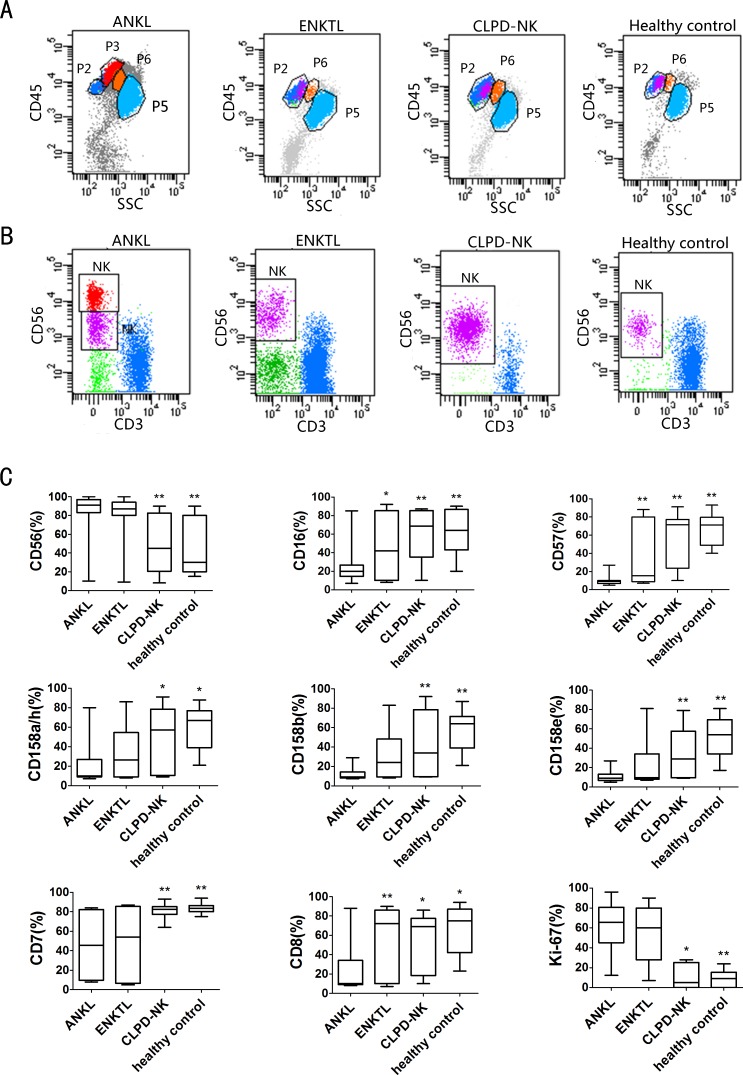
Comparison of immunophenotypic characteristics among samples from different NK diseases and healthy control detected by flow cytometry.(A) Abnormal NK cells from patients with ANKL (red P3 group) were separated from lymphocytes (dark blueP2 group)based on the abnormal expression of the CD45 antigen when aCD45/SSC gating strategy was used. In contrast, in the patients with ENKTL or CLPD-NK and in the healthy controls (purple cell group in P2 group), NK cells usually overlapped with lymphocytes (dark blue P2 group).(B) The NK cells from patients with ANKL could be separated based on aCD56bright (red cell group) and CD56dim (purple cell group) phenotype when a CD56 gating strategy was used. In contrast, in the patients with ENKTL or CLPD-NK and in healthy controls, the NK cells (purple cell group) did not show this phenomenon. (C) The immunophenotypes for the 3 NK cell diseases tested and the healthy controls shown with the extent of expression for each antigen. Abnormal NK cells in patients with ANKL had lower expression levels of CD16, CD57 and CD8 than those from the patients with ENKTL (p<0.05). The expression levels of CD16, CD57, KIR (CD158a/h, CD158b, CD158e), CD7 and CD8 in abnormal NK cells in from the patients with ANKL were significantly decreased compared to those measured in the patients with CLPD-NK; whereas CD56 and Ki-67 were markedly more strongly expressed in the patients with ANKL than in the patients with CLPD-NK.* p<0.05, ** p<0.01.